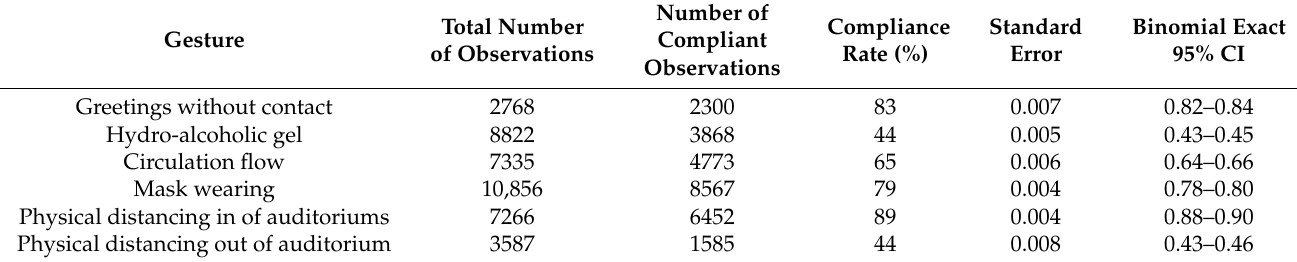
Table A2. Compliance rate for barrier gestures implementation and confidence interval from the